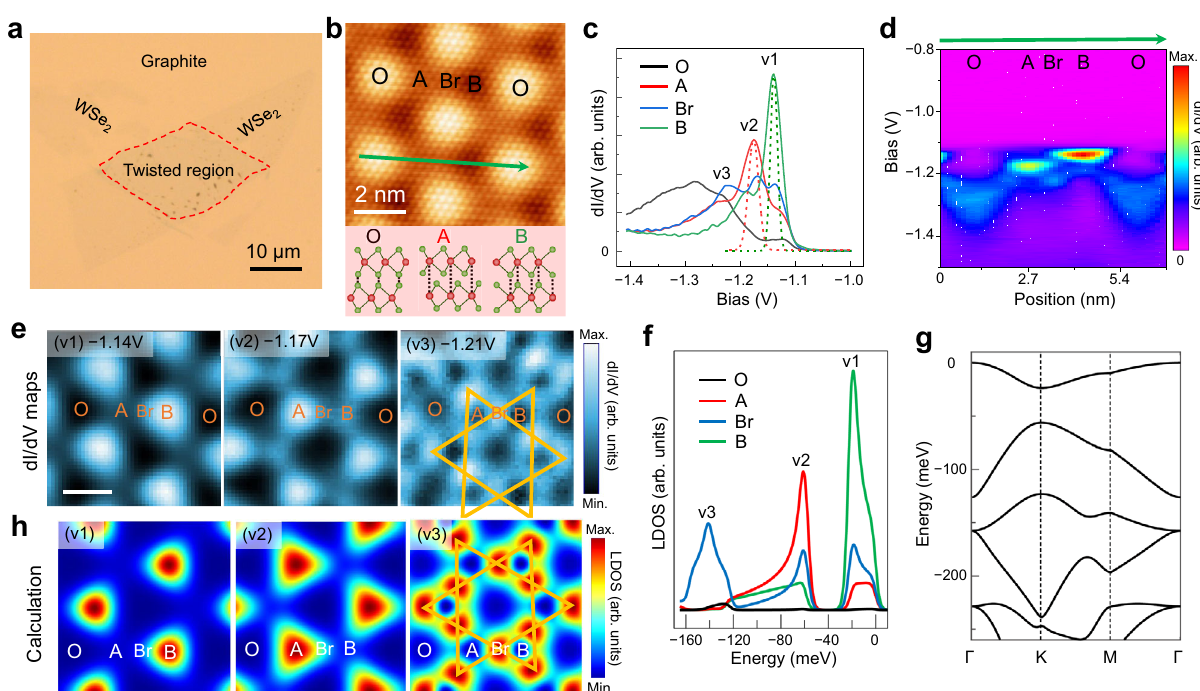
Fig. 1 STM/STS measurement on 54.1° TB-WSe 2 . a Optical image of 54.1° TB-WSe 2 sample. The red-dashed box highlights the twisted region. b Top: an atomic-resolution STM topographic image ( − 1.5 V, 600 pA) of 54.1° TB-WSe 2 . Bottom: a schematic side view of stacking con fi gurations between two WSe 2 layers: O, A, B. Green: Se; Red: W. c d I /d V spectrums ( V = − 1.5 V, I = 500 pA, V mod = 10 mV) near VB edge acquired at the center of four moiré sites. The dashed green (red) curve is the estimated intrinsic v1 (v2) peak from Gaussian fi tted peak in region B (A), respectively. d Conductance map taken along the green line in panel b , V = − 1.5 V, I = 1 nA, V mod = 10 mV. e d I /d V maps at − 1.14 V (v1), − 1.17 V (v2) and − 1.21 V (v3). Scale bar: 2 nm. f Calculated LDOS at four moiré sites, showing the site-dependent peak intensity in moiré lattice. g Calculated electronic band structure plotted in the folded moiré Brillouin zone. Note that the valence band edge is set at E = 0. h Calculated LDOS maps at the energy of v1, v2, and v3, respectively, agree well with experimental results shown in e acquired at the center of three moiré sites, revealing the isolated sharp band-edge peaks (in green) at B sites near the VB edge. Figure 2c, f, i, l show the line-mode conductance maps acquired point-by-point along the green line in the corresponding STM image in Fig. 2, displaying the evolution of the electronic states near the VB edge at gradually increased twist angles. The 57° TB- WSe 2 ( l : ~6.3 nm) features two states (v1 and v2) near the VB edge that are separated by ~66 meV in energy, as marked by two white arrows in Fig. 2c. Both states are localized in region B but their spatial distributions are very different: v1 is distributed at the center region while v2 is distributed at the two sides having a central “ node ” . As the twist angle further increased to 57.4° ( l : ~7.2 nm) and 57.8° ( l : ~8.6 nm), we observed three (v1, v2, and v3) and four (v1, v2, v3, and v4) energy-separated states that were localized in the region B, respectively. The distributions of v1 and v2 are similar to those of the 57.0° sample. The v3 state has two nodes and the v4 state has three nodes. As will be shown below, these nodes are related to the quantum well states caused by lattice reconstruction. For the 58.4° TB-WSe 2 sample ( l : ~11.8 nm), a sequence of states emerges in region B as shown in Fig. 2k, l. Apart from the increased states numbers, the energy separation of observed states decreases as the twist angle approaches 60°. Note that the slight concave-up streaks of these states distribution are likely due to tip-induced band bending (TIBB) effects, similar behavior has been observed in aligned MoS 2 /WSe 2 heterobilayer 38 . The continuum model with the V M r ð Þ moiré potential (Methods) can well describe the states in 54.1° TB-WSe 2 , however, we fi nd it fails to interpret the quantum-well-like states observed in the 57°-58.4° samples (Supplementary Fig. 5). This